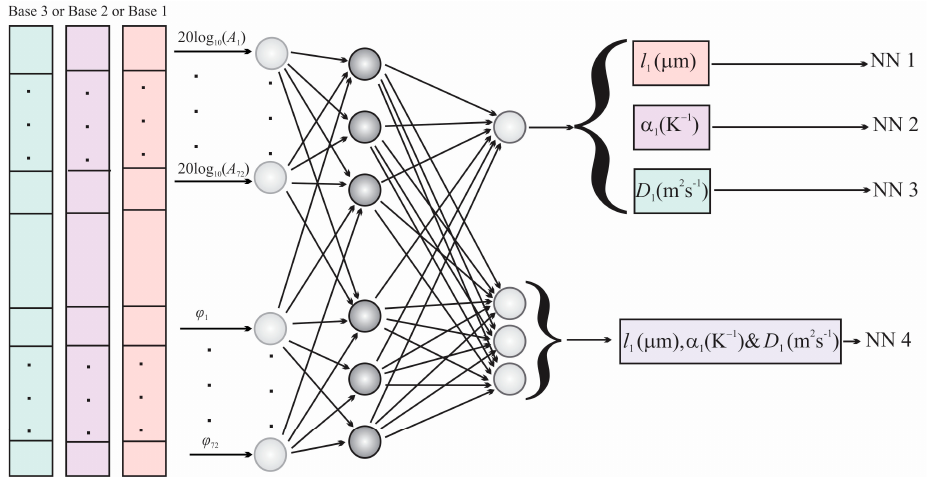
Figure 4. A representation of the structure of a single − layer neural network used for the training and prediction of TiO 2 thin − film parameters.